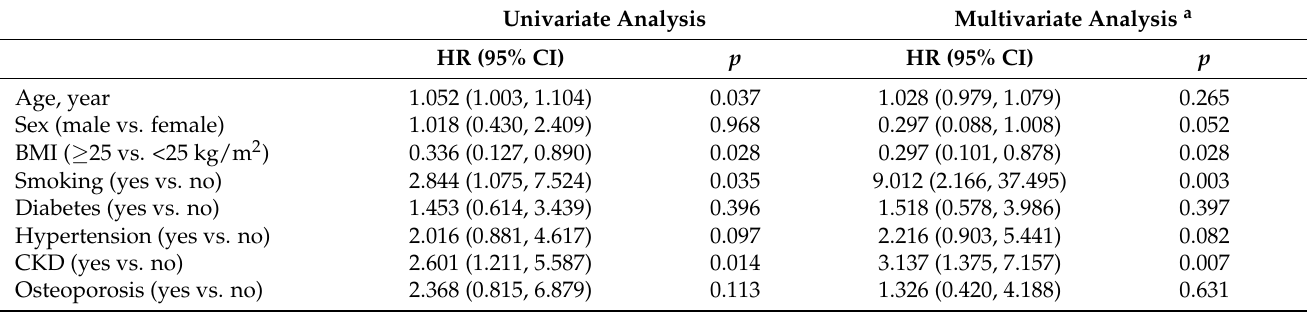
Table 2. Associations of baseline characteristics with all-cause mortality of the study sample.